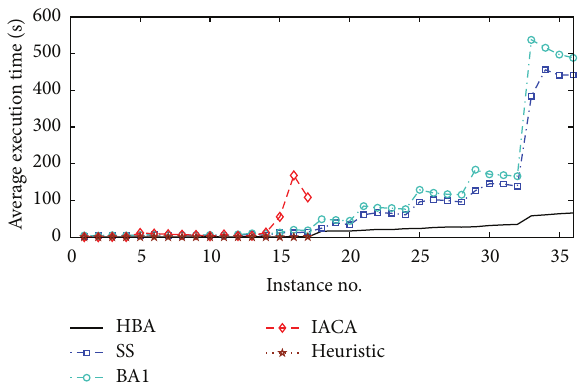
Figure 7: The computational time of each test